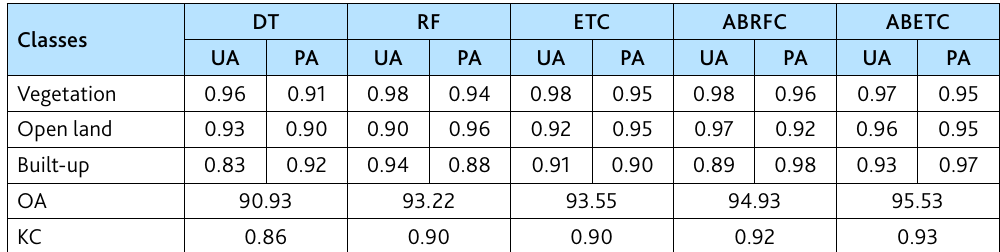
Table 5. Accuracy Statistics comparison for DT, RF, ETC, ABRFC, and ABETC Classifiers for Rajkot 2021